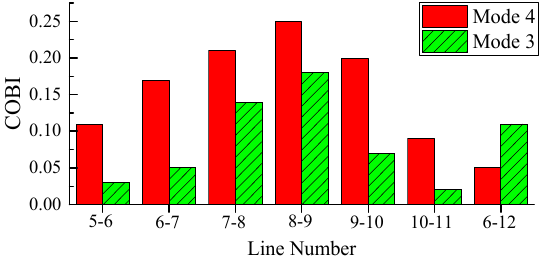
Figure 8. The joint modal controllability/observability index (COBI) of line active power as the input feedback signal of SVC POD.